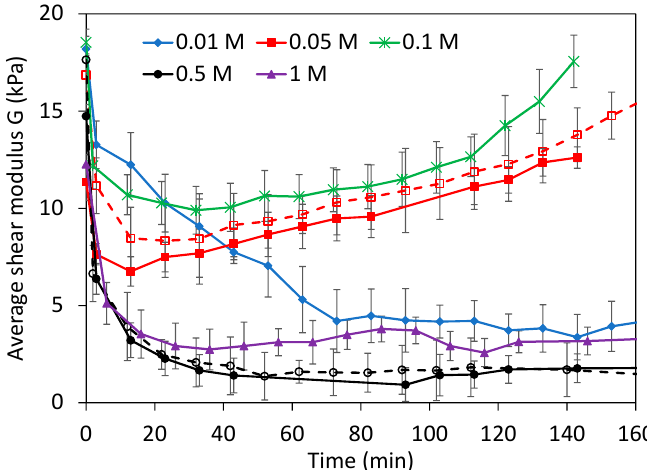
Figure 10. Shear modulus in WPI gels undergoing dissolution at different (NaOH). Moduli were calculated as the average between 50–500 μ m indentation depth. Empty points and dashed lines are used for repeated experiments. Error bars are as in Figure 5.